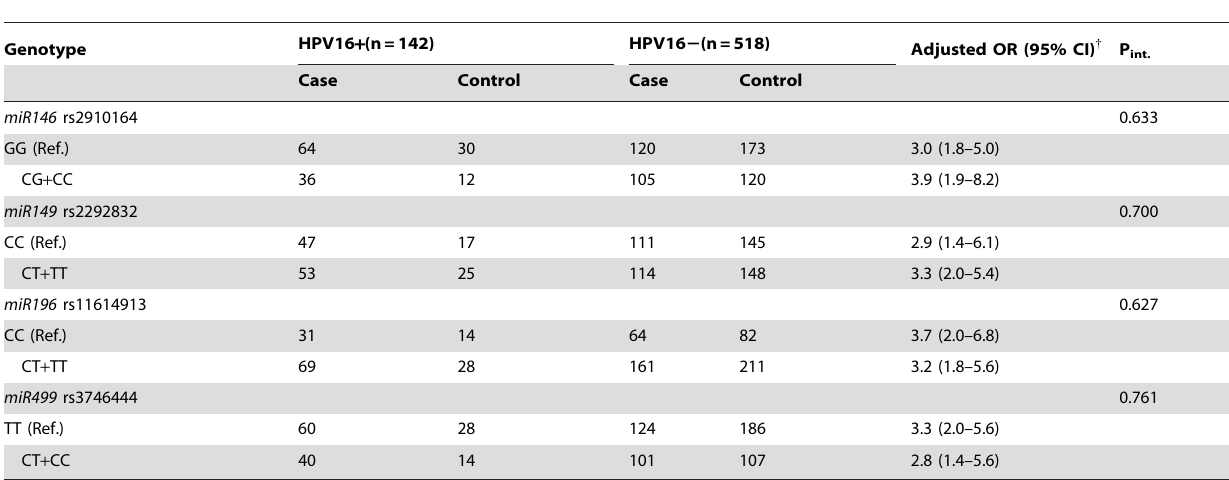
Table 5. Modifying effect of microRNA variants on association between HPV16 Seropositivity and OSCC risk.